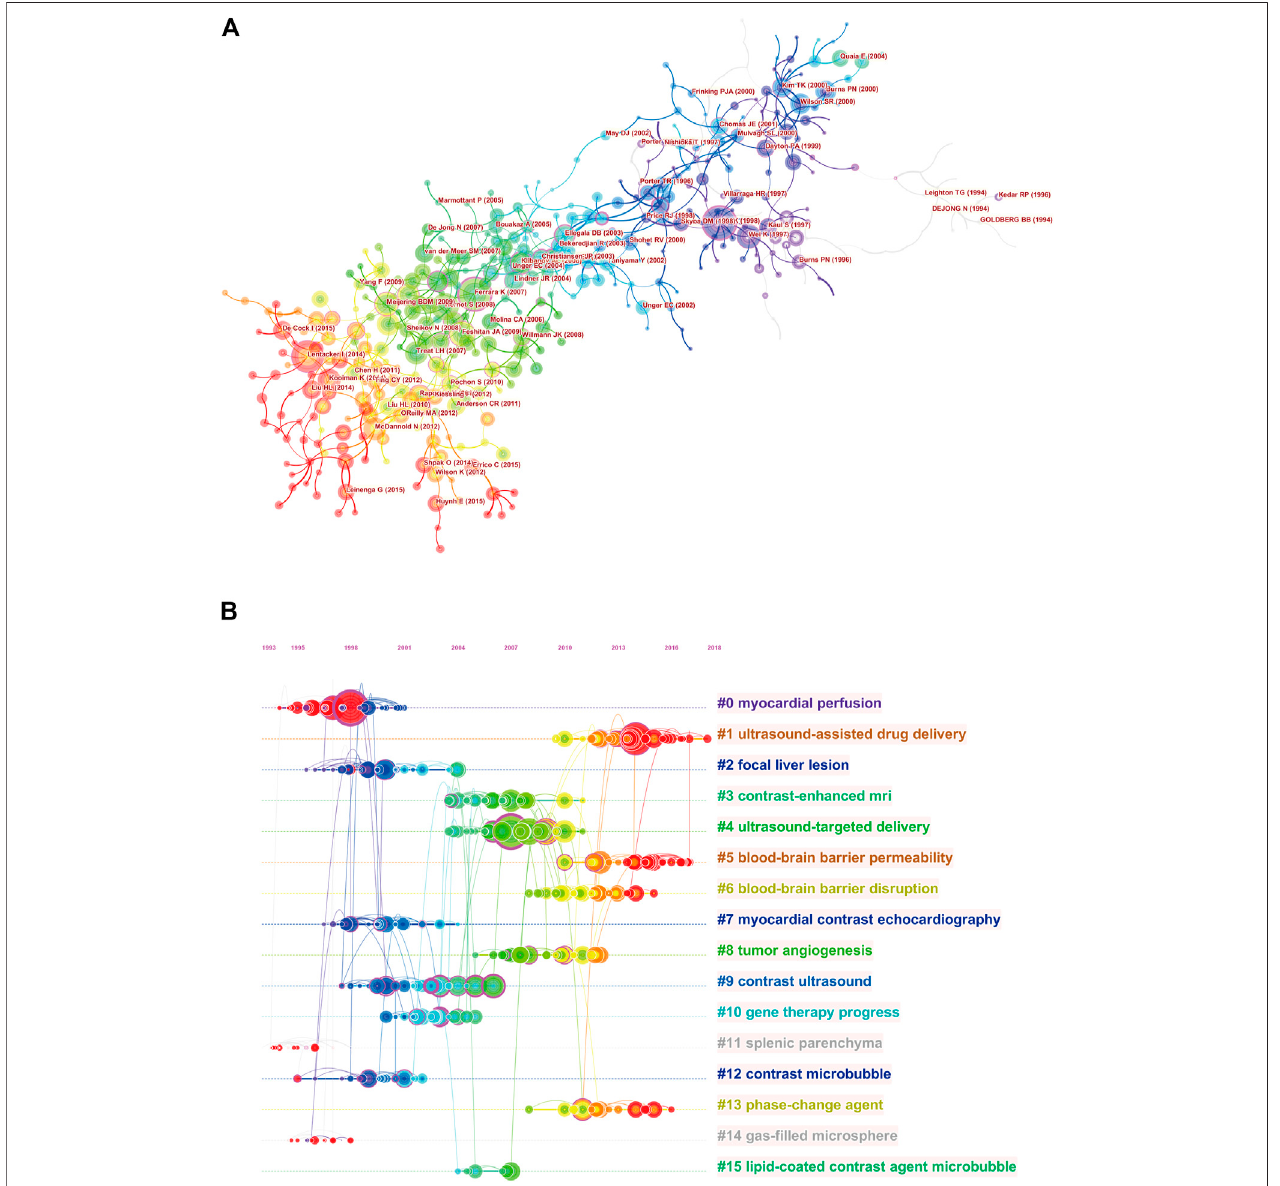
FIGURE 8 | Cluster view (A) and timeline view (B) of cocitation reference. The clusters are arranged vertically in descending order according to their size. Sixteen majorclustersarelabeled andcolor-codedontheright. Thetimeevolutionisshown withdifferentcoloredlines.Thenodes onthelinesindicatethereferencescited,and the links indicate the references cited together. The density of nodes at different time periods can re fl ect the dynamic changes of the corresponding clusters on the time axis.